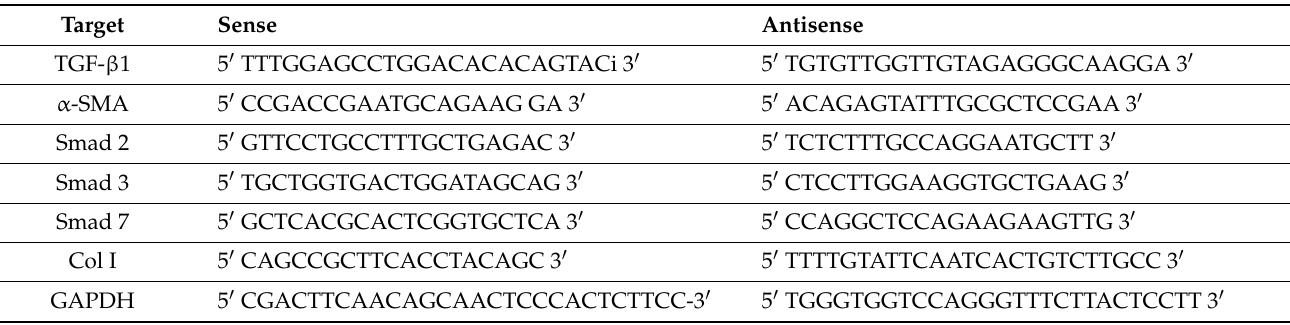
Table 1. Primer sequences for